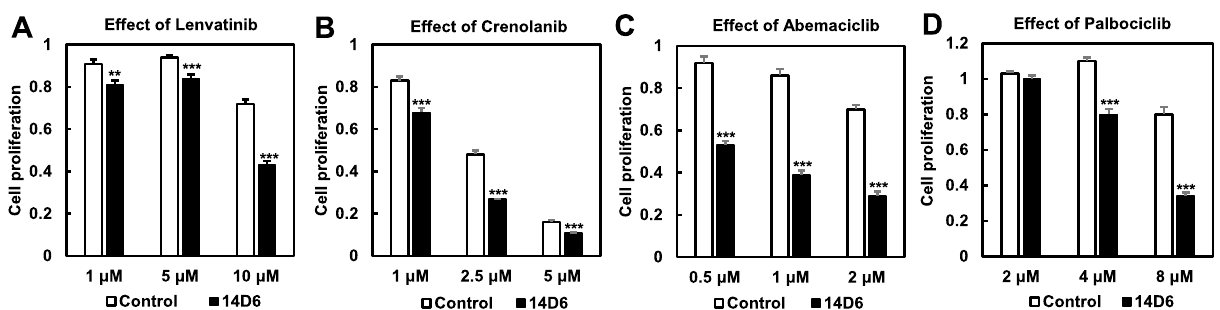
Figure 6. Impact of kinase inhibitors on the proliferation of c.1403A > G PDGFRA -mutated HEK293T cells. (A–D) The multi-kinase inhibitor, lenvatinb (A) , the receptor tyrosine kinase inhibitor crenolanib (B) , and the CDK4/CDK6 inhibitors abemaciclib (C) and palbociclib (D) inhibited the proliferation of 14D6 cells more strongly than that of isogenic control